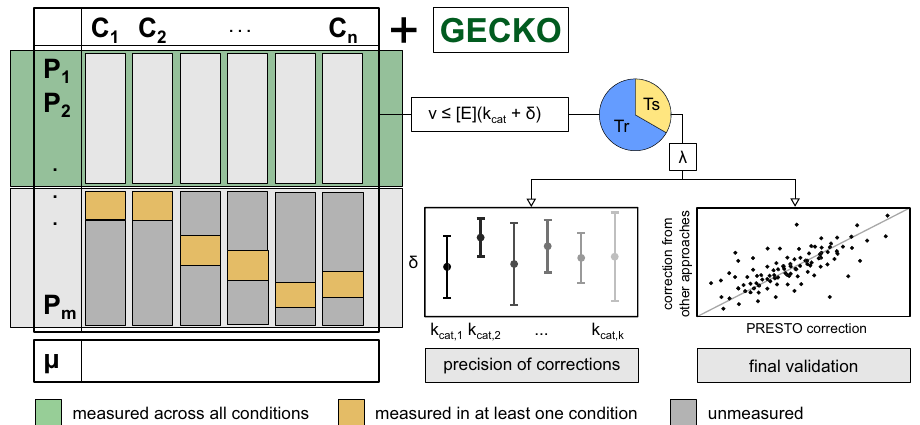
Fig. 1 | Schematic overview of the PRESTO approach for k cat correction. The approach uses a GECKO-formatted pcGEM 7 containing turnover numbers from BRENDA 48 . Using available data from n experimental conditions, n condition- speci fi c models are generated using nutrient uptake rates and protein contents.